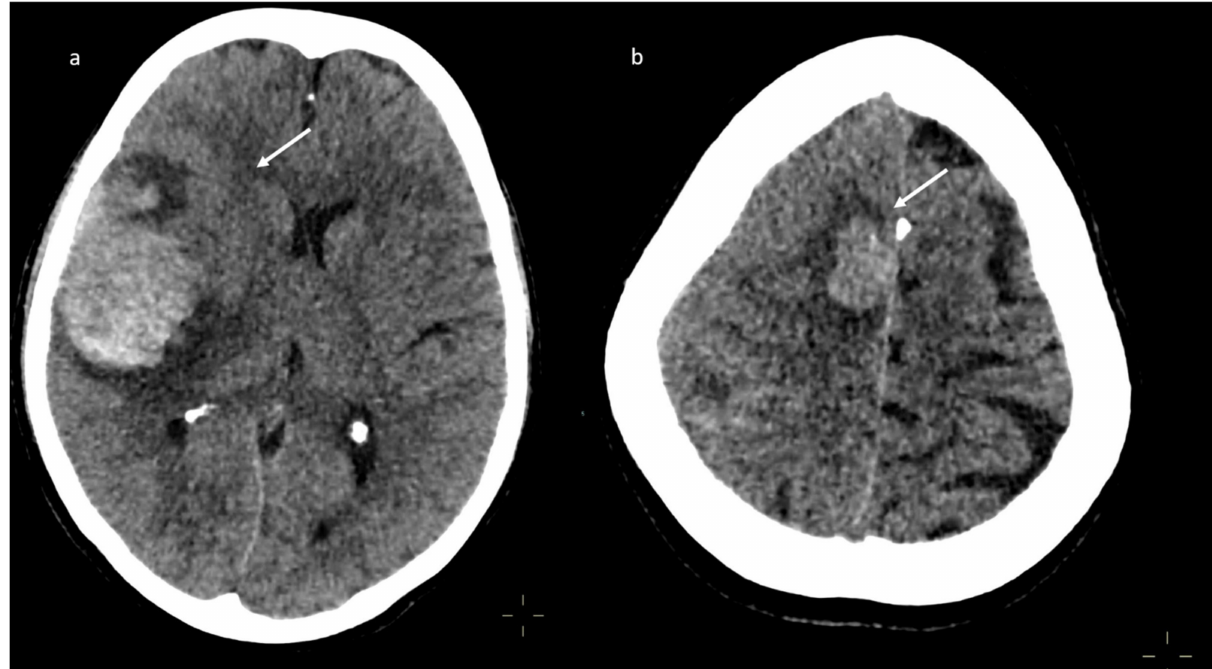
Figure 1. Brain computed tomography (CT) scan: presence of multiple subacute intra-axial hemorrhages in atypical locations ( a , b